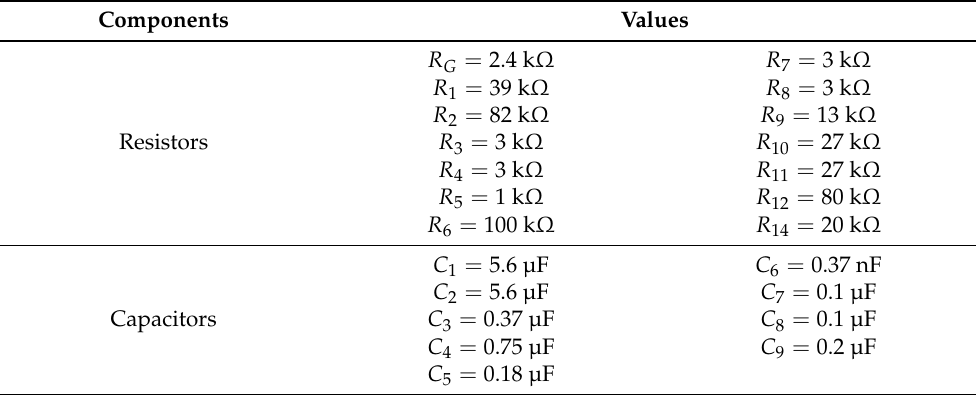
Table 2. Components values of the second signal conditioning